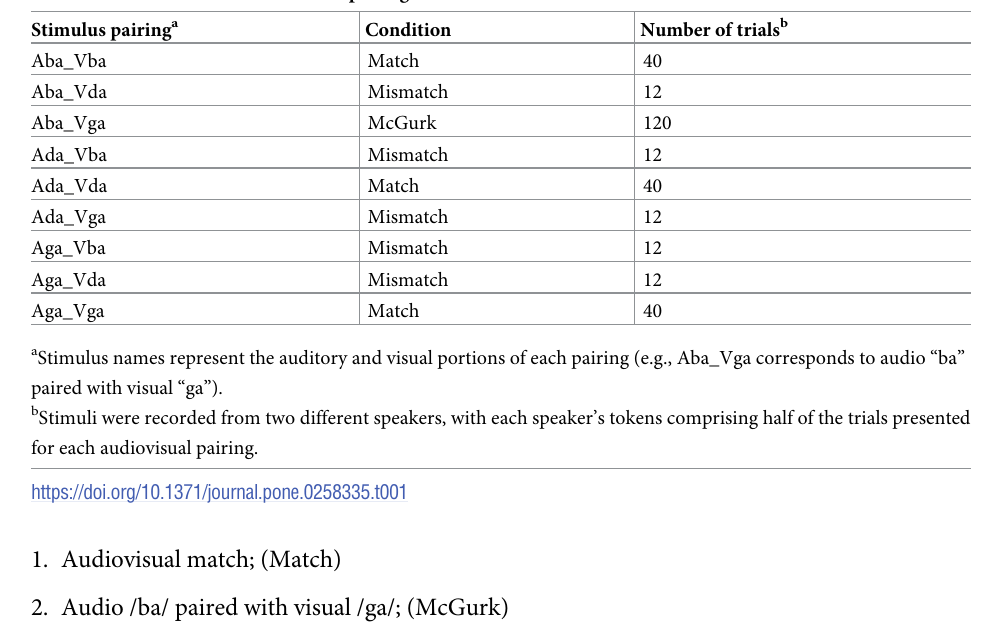
Table 1. Contributions of audiovisual pairings to stimulus conditions. Stimulus pairing a